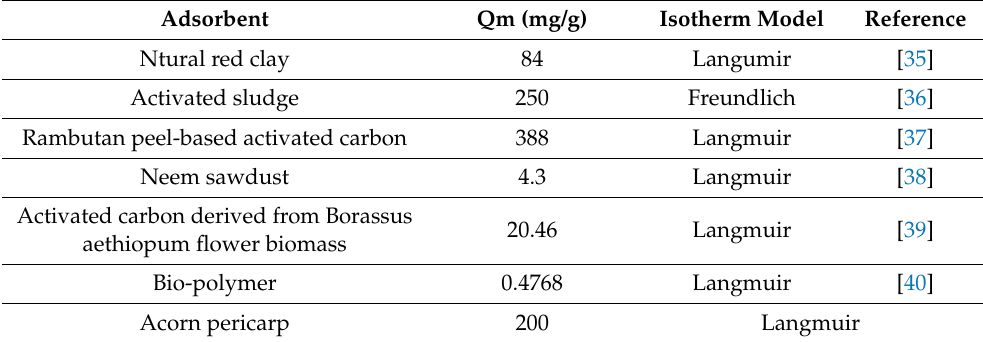
Table 5. Adsorption capacity of MG using different adsorbents reported in